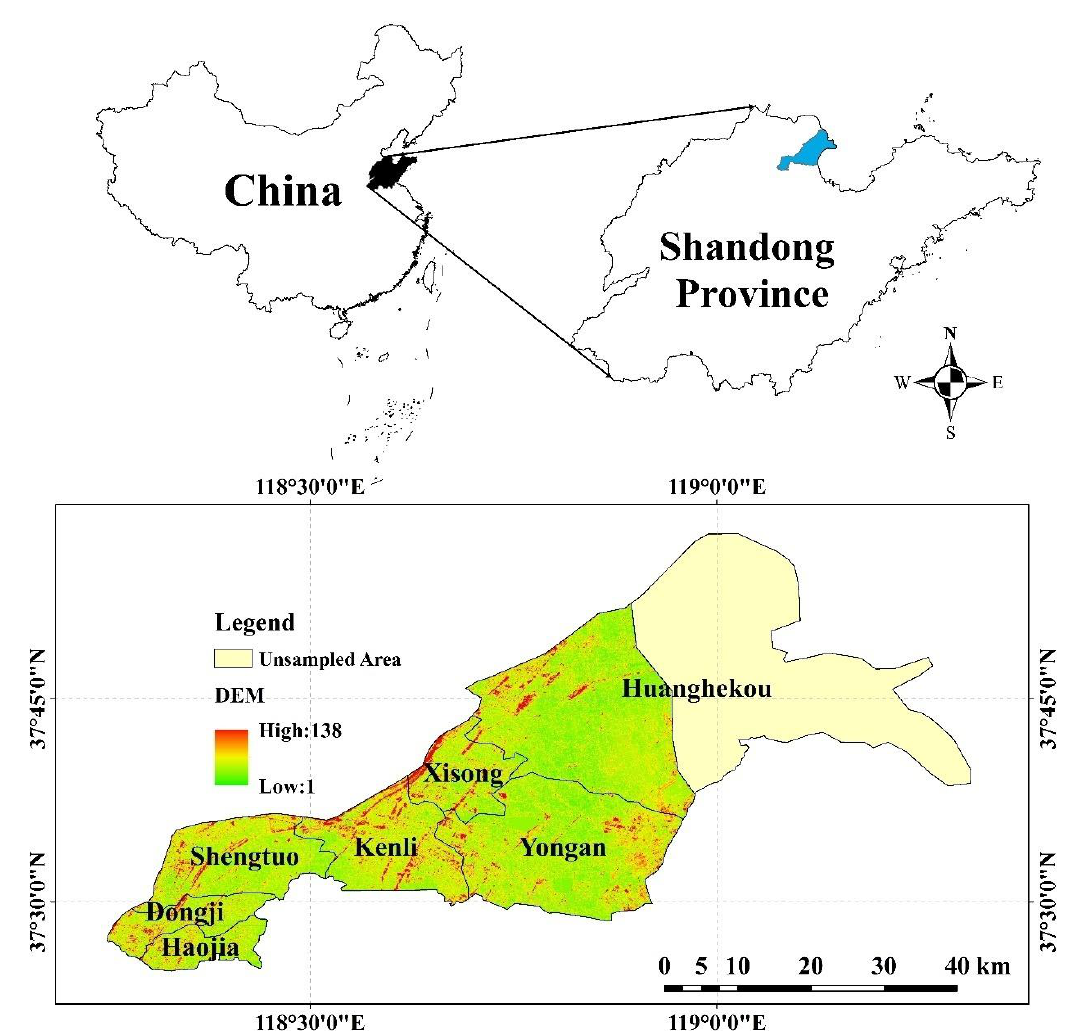
Figure 1. Location and elevation of Kenli County in Yellow River Delta.